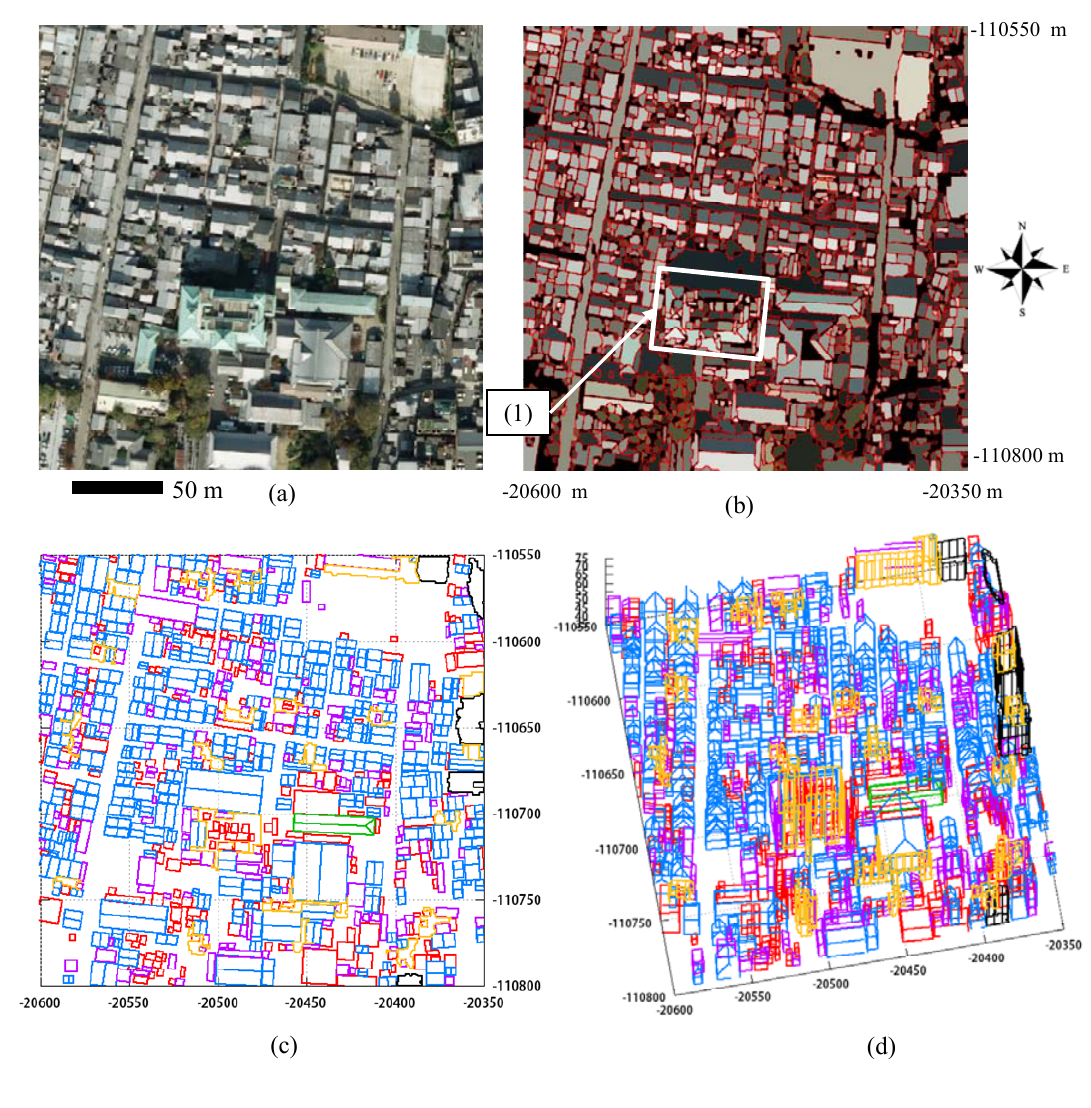
Figure 12. ( a ) Aerial image, ( b ) segmentation results, and ( c ), ( d ) modeling results for another area containing low-rise buildings and high-rise and complex buildings. Wireframe models are as in Figure